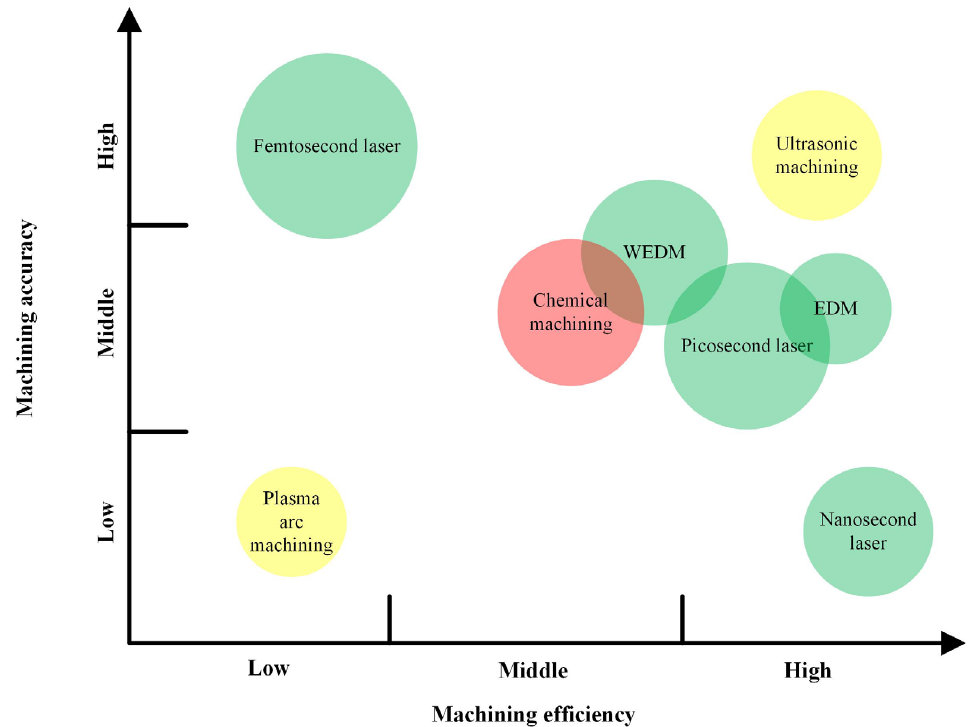
Figure 9. Machining efficiency, precision, cost and environmental impact of different nontraditional machining methods of UHTCMCs. (The radius of the circle indicates the machining cost; the larger the radius, the higher the cost. The color of the circle indicates the environmental impact of manufacturing, while green, yellow and red indicate small, medium and large impacts).